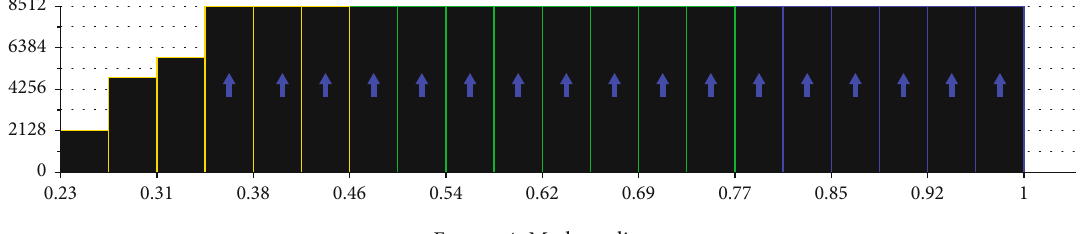
Figure 4: Mesh quality.